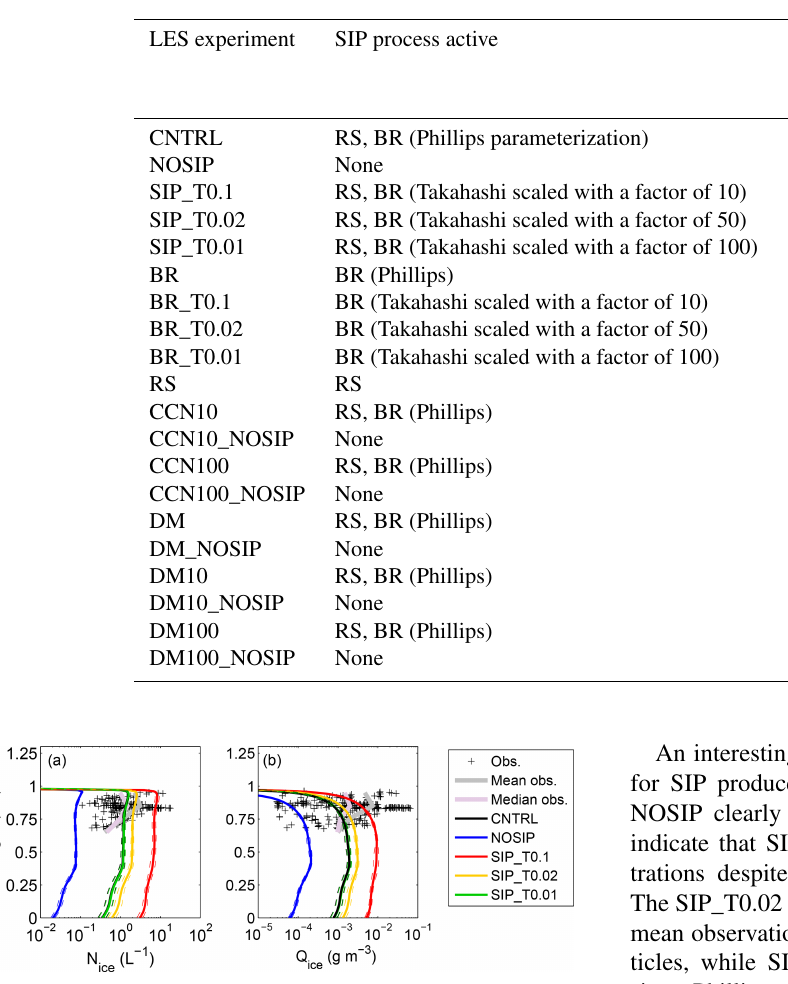
Figure 5. Vertical profiles of (a) ice crystal number concentration ( N ice ) and (b) ice mass mixing ratio ( Q ice ) for CNTRL (black), NOSIP (blue), SIP_T0.1 (red), SIP_T0.02 (yellow) and SIP_T0.01 (green) from the LES. Solid lines represent the mean profiles, av- eraged between 4 and 8h of simulation time, while dashed lines show the standard deviation. Black crosses represent the measure- ment range derived from the 2-D-S probe, while grey (pink) lines represent the observed mean (median)